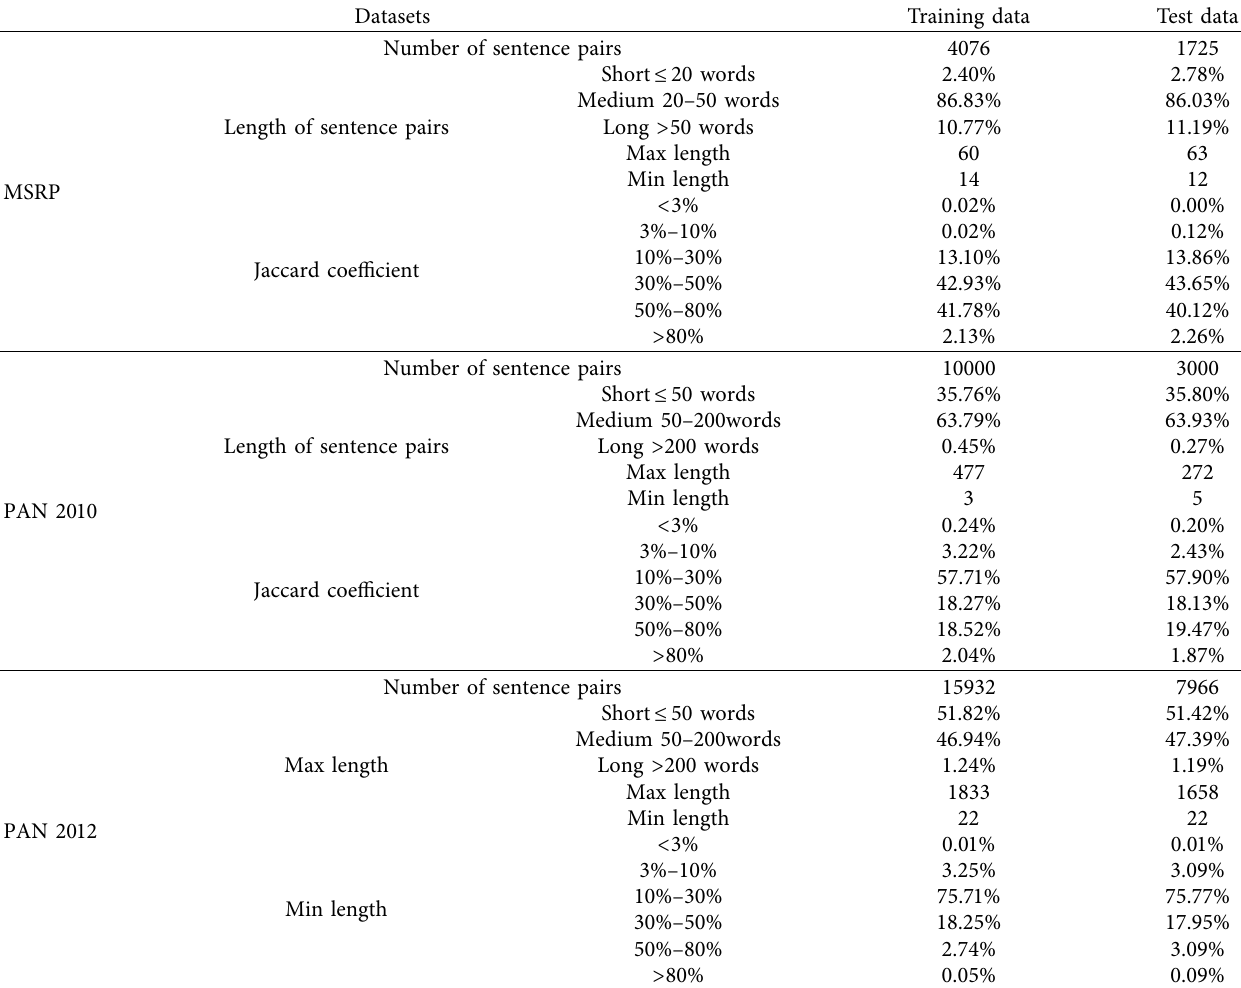
Table 1: The statistics of the